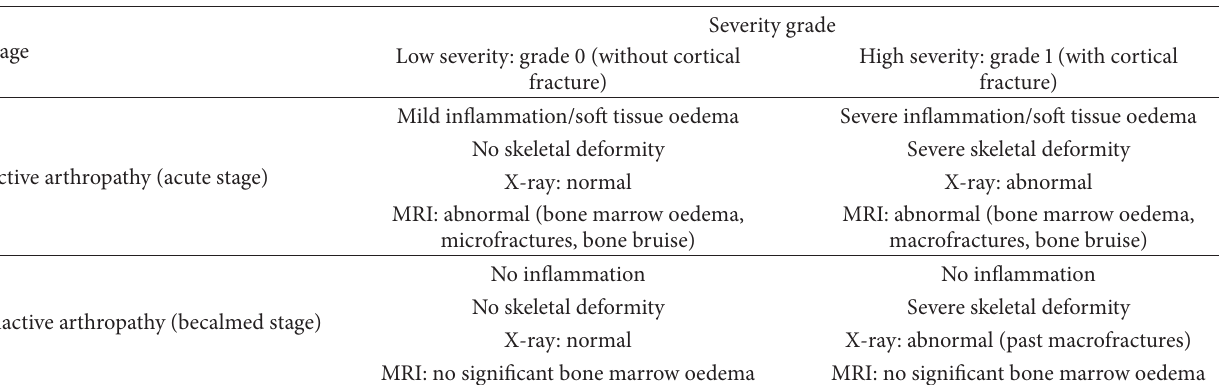
Table 2: Classification of CN based upon MR imaging. Source: